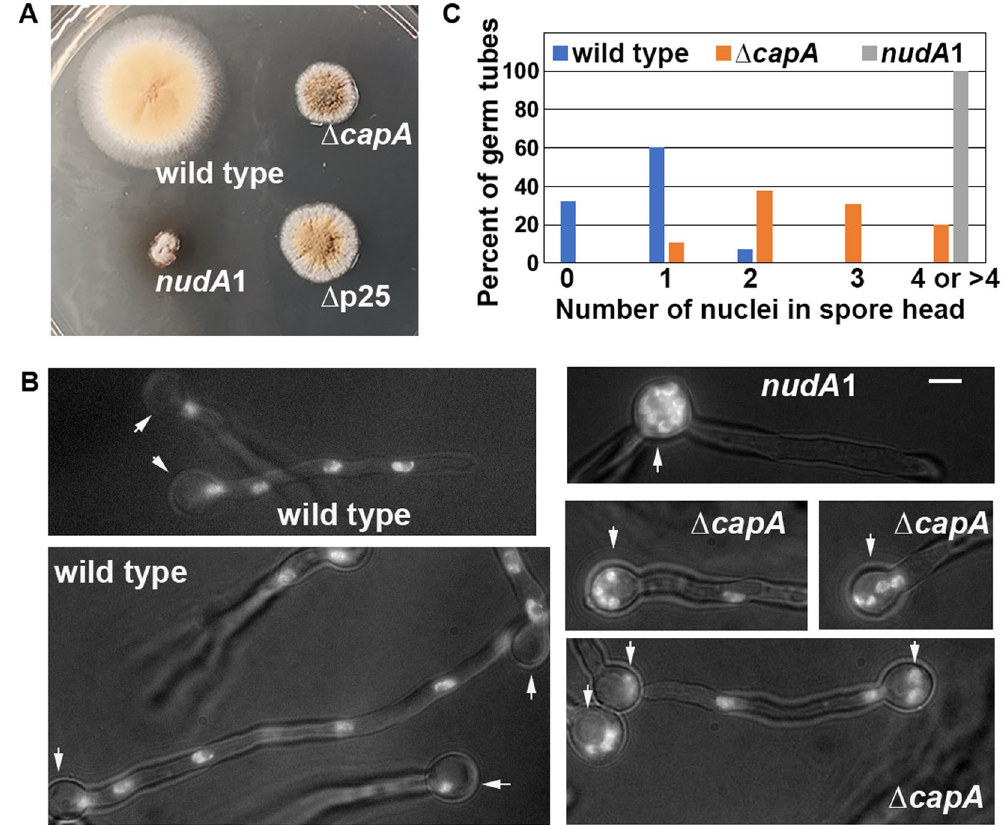
Figure 2. Colony and nuclear-distribution phenotypes of the ∆ capA mutant. ( A ) Colony phenotypes of the ∆ capA mutant and control strains including wild type, the nudA 1 mutant and ∆ p25 mutant. The plate was incubated at 37 °C for 2 days. ( B ) Images showing the nuclear distribution phenotype of the ∆ capA mutant in comparison with that of wild type or the nudA 1 mutant. Cells were grown at 37 °C for ~8 hours in MM + glucose medium. Bar, 5 μ m. ( C ) A quantitative analysis on the percentage of germ tubes containing 0, 1, 2, 3 or ≥ 4 nuclei in the spore head. In the wild-type control strain, 60.3% of the germ tubes contain one nucleus, 32.4% contain no nucleus and 7.3% contain two nuclei in the spore head (n = 68). In the ∆ capA mutant, 10.7% contain one nucleus, 38.1% contain two nuclei, 31% contain three nuclei, 17.8% contain four nuclei and 2.4% contain five nuclei in the spore head (n = 84). The mean ranks of these two sets of data are significantly different at p = 0.05 (the actual p -value is smaller than 0.000000000000001, two-tailed) based on a nonparametric test that assumes no information about the distribution (unpaired, Mann-Whitney test, Prism 7 for Mac OS X, version 7.0c, 2017). In the nudA 1 mutant, 100% of the germ tubes (n = 50) show a cluster of 4–8 nuclei in the spore head, and we express the number as “4 or > 4” because the exact number of nuclei in the cluster is hard be determined